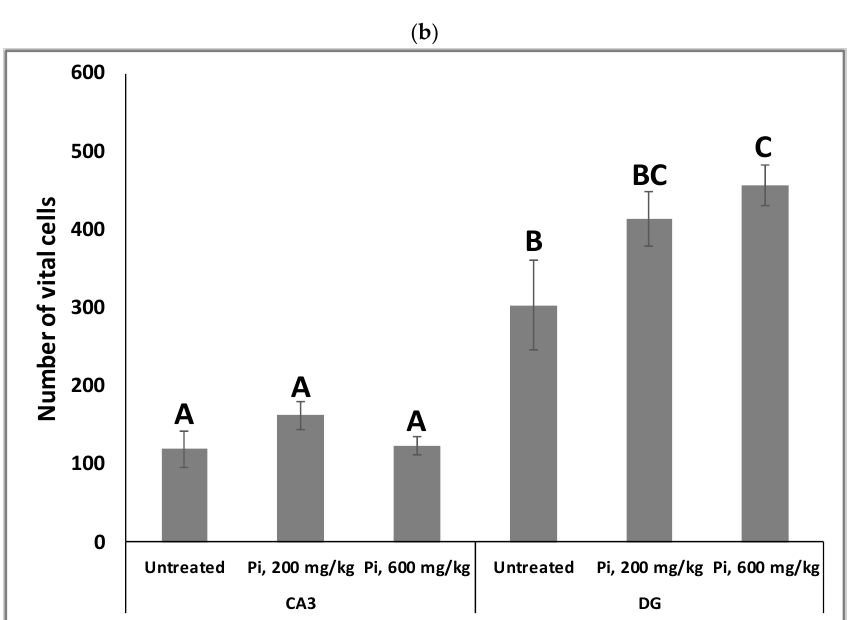
Figure 8. Consumption of Pi infusion enhances the viability of hippocampal neurons in aged mice. Brain sections of 19 months old mice treated daily for 18 months with Pi infusion, were stained with hematoxylin and eosin for morphometric analysis of the number of hippocampal neurons in the cornu Ammonis 3 (CA3) and dentate gyrus (DG) regions, as viewed through an objective magnification of X20. The percentage of pyknotic neurons was calculated as the number of pyknotic neurons out of the total number of neuronal cells (vital + pyknotic). The results are presented as mean ± SEM (n = 9 ) . Columns marked with different letters (A, B, C) represent statistically significant differences p < 0.05.